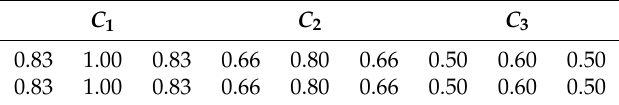
Table 4. Normalized specific